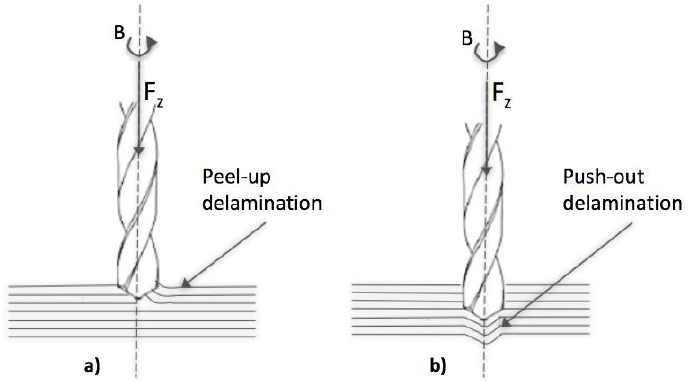
Figure 1. ( a ) Peel-up and ( b ) push-out delamination induced by drilling of fibre reinforced plastic (FRP) laminates.